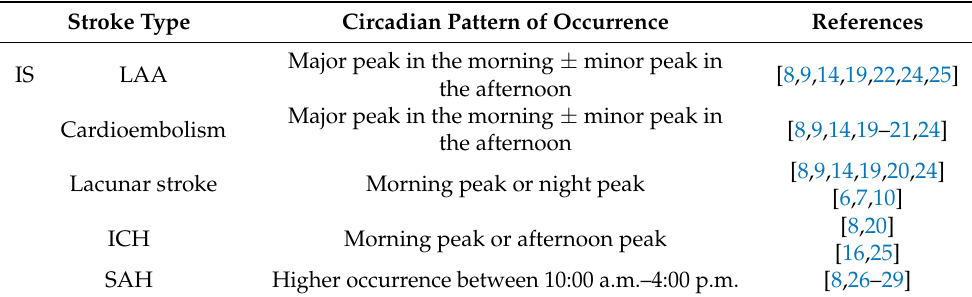
Table 1. Circadian variation in stroke occurrence according to stroke